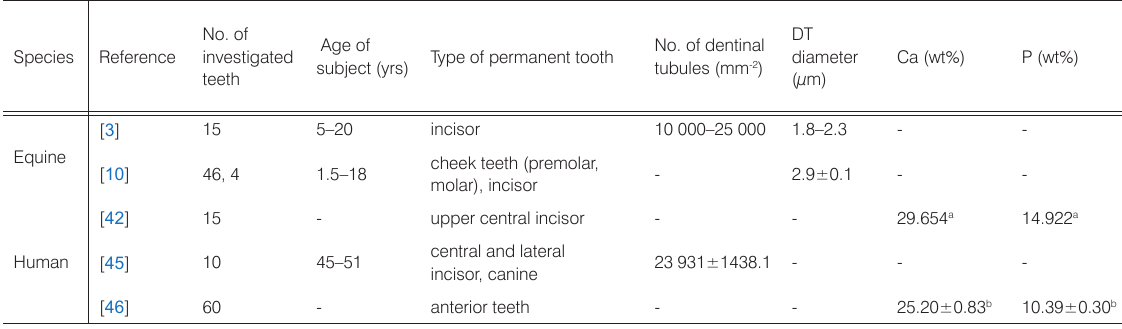
Table 1. Data on dentin microstructure, and Ca and P characteristics of human and different animal species.